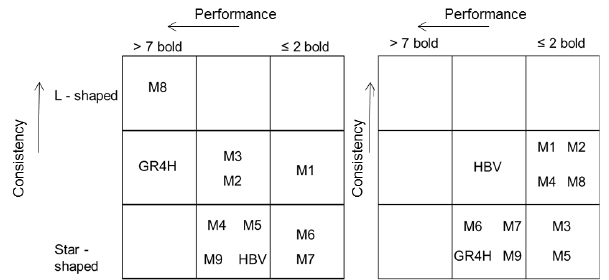
Fig. 10. Overview of the performance (columns) and consistency (rows) of the Maimai (left) and Wollefsbach (right). The middle row and column indicate a medium consistency and performance. The location of the model structures in this overview is determined based on visual inspection. There is only a difference between the squares: the exact position of a model structure within a square is arbitrary. The PCA configurations for a high consistency (line- shaped) are not presented in this figure, as those configurations did not occur among the results.